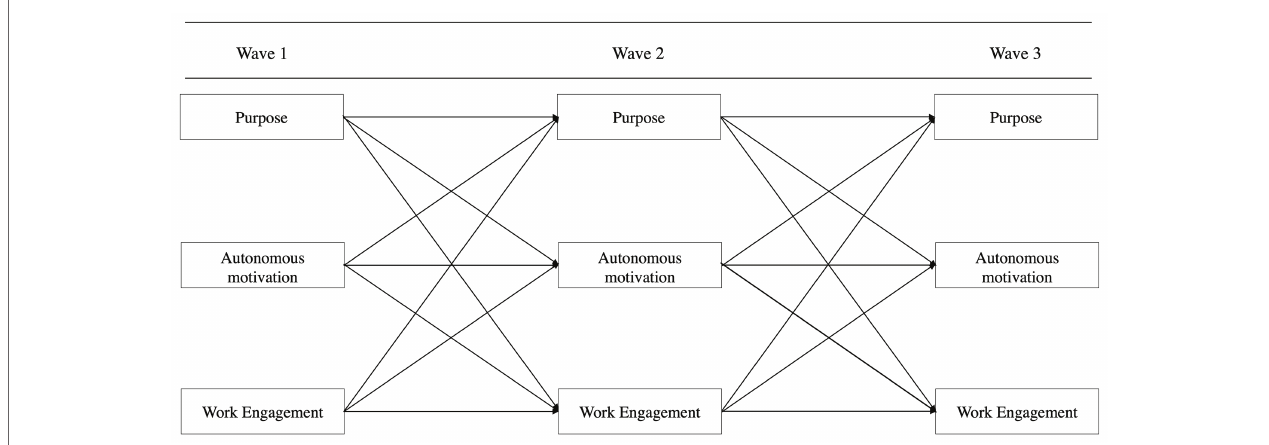
FIGURE 2 | The cross-lagged panel model as used in Study 2 examines the crossed relationships from purpose to autonomous motivation and engagement.